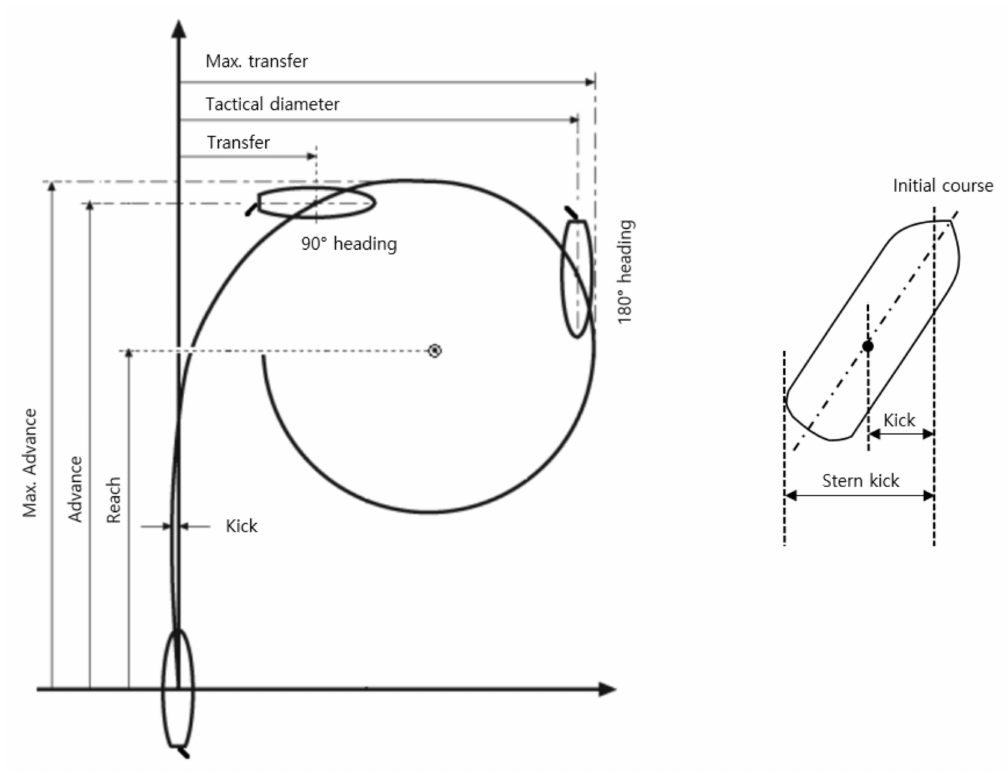
Figure 3. Turning circle and